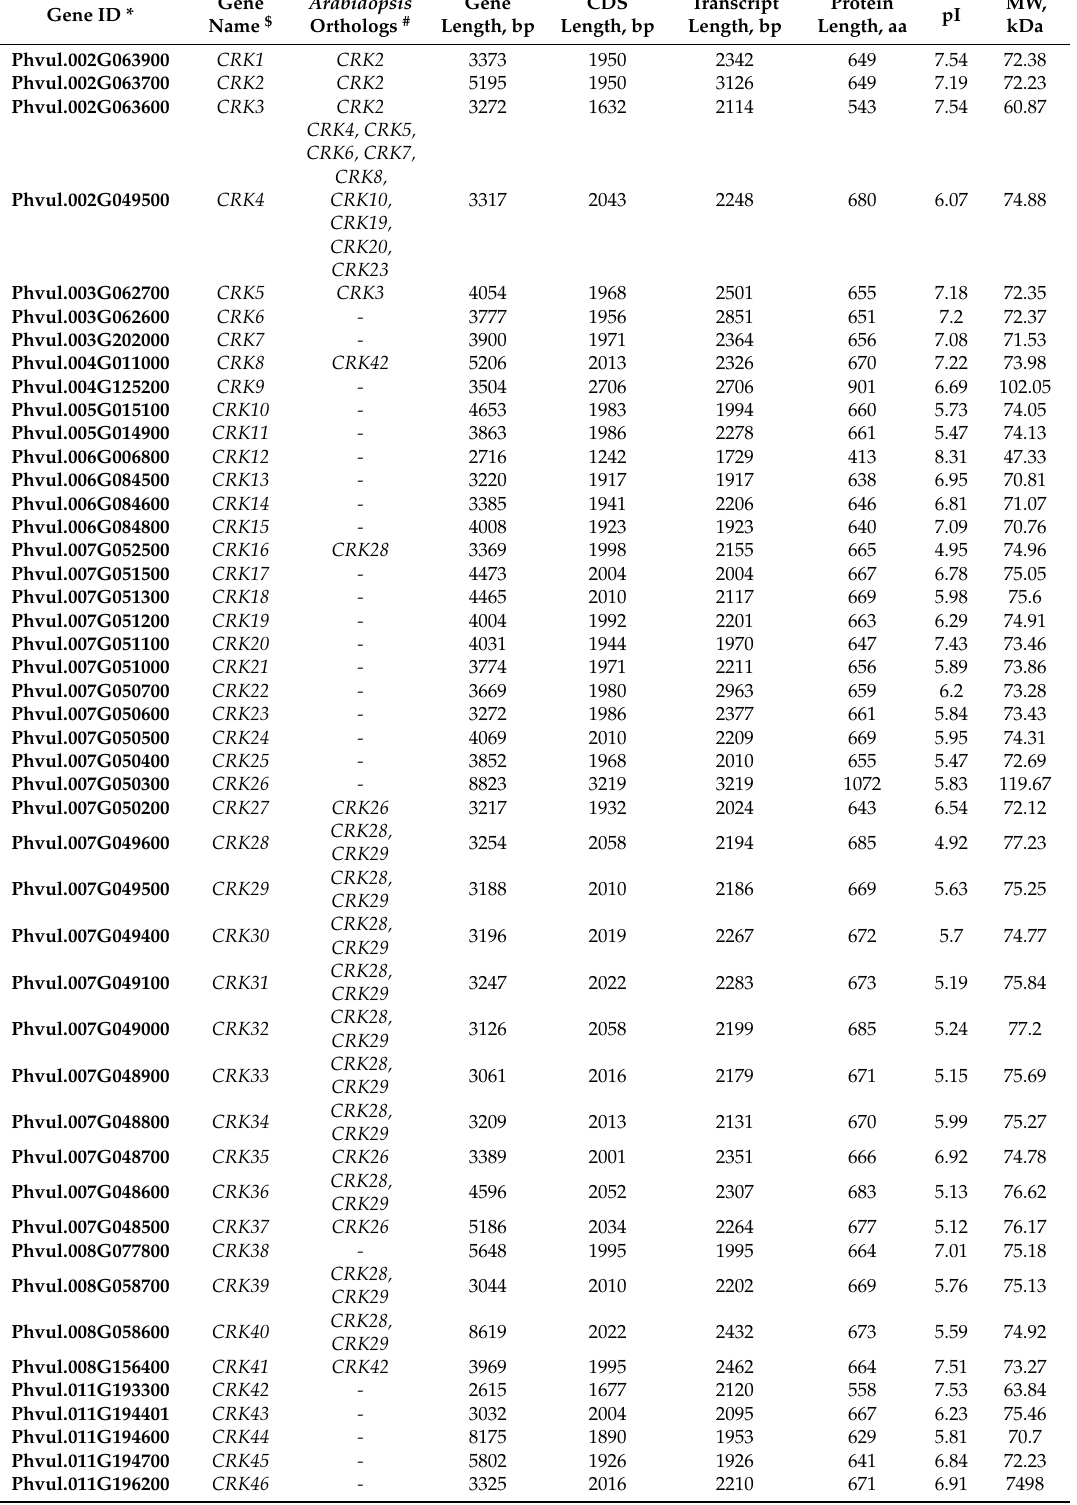
Table 1. The CRK gene family members in Phaseolus vulgaris